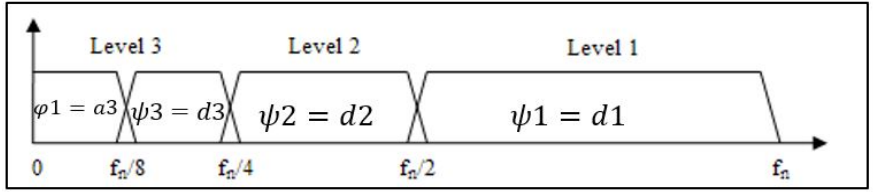
Figure 11. Decomposition at level 3: f(t)=d1+d2+d3+a3